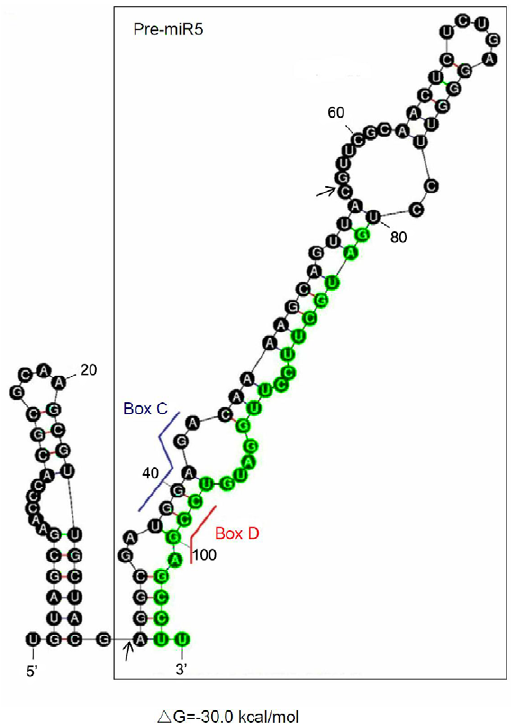
Figure 3. MFOLD predicted structure of snoRNA GlsR2. The sequence of the full-length GlsR2 was submitted to the MFOLD RNA server. Putative box C and box D of GlsR2 are marked by the blue and red line, respectively. The 75 nt miR5 precursor, pre-miR5, folds into a hairpin structure suitable for Dicer cleavage (black boxed). miR5 is located in the stem region of the hairpin at the 3 9 end and colored in green. The arrows showed the 5 9 and 3 9 ends of the 25 nt small RNA discovered from deep sequencing library which could be